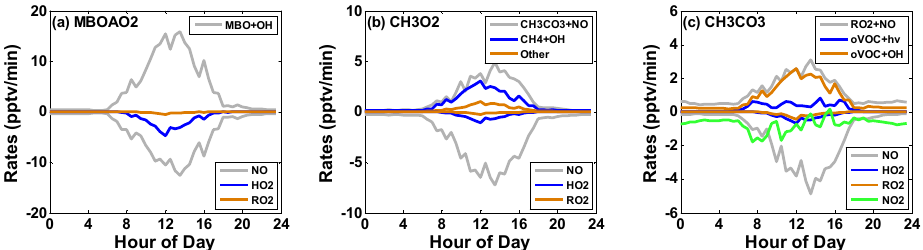
Fig. 10. Modeled chemical tendencies for three representative organic peroxy radicals: (a) MBOAO2, (b) methyl peroxy radical and (c) acetyl peroxy radical. In (c) , the loss rate attributed to NO 2 (green line) represents the net effect of PAN production and decomposition. Model results are taken from the base